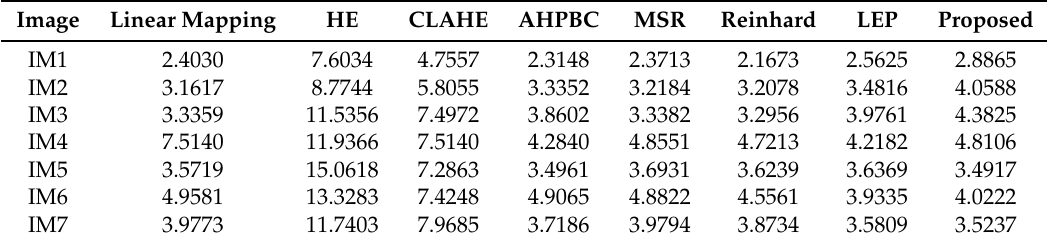
Table 4. The Naturalness Image Quality Evaluator (NIQE) values of the images. Image